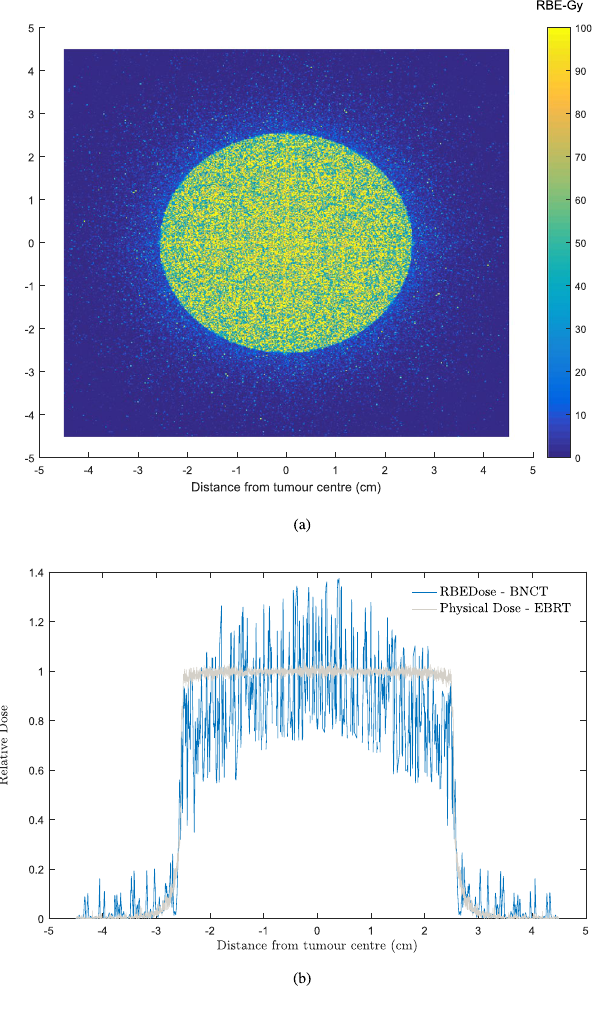
Figure 4. Cell-based RBE dose using equation (4) and four Geant4-calculated cellular dose matrices. ( a ) RBE dose distribution in the scoring plane versus distance from the tumour centre. ( b ) Transverse RBE dose in the scoring plane versus distance from tumour centre. The transverse profile for x-ray EBRT 34 is also shown as a comparison. The statistical uncertainty of the calculated results (the relative error between several runs) was ∼±